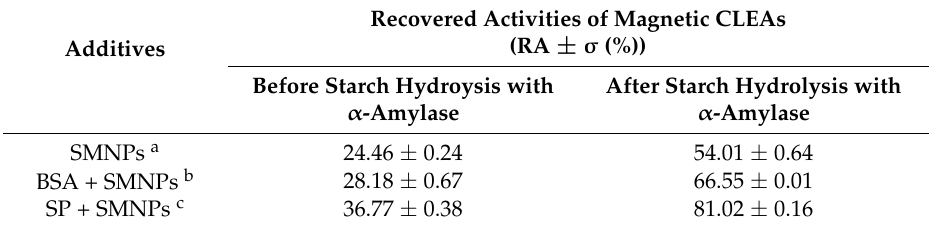
Table 3. Evaluation of different additives in the preparation of porous magnetic CLEAs (pm-CLEAs) of porcine pancreas lipase (PPL). The values of the immobilization parameter RA (recovered activity) are expressed as average of triplicates ± standard deviation ( σ ). Recovered Activities of Magnetic CLEAs (RA ± σ (%)) Additives Before Starch Hydroysis with After Starch Hydrolysis with α -Amylase α -Amylase SMNPs a 24.46 ±